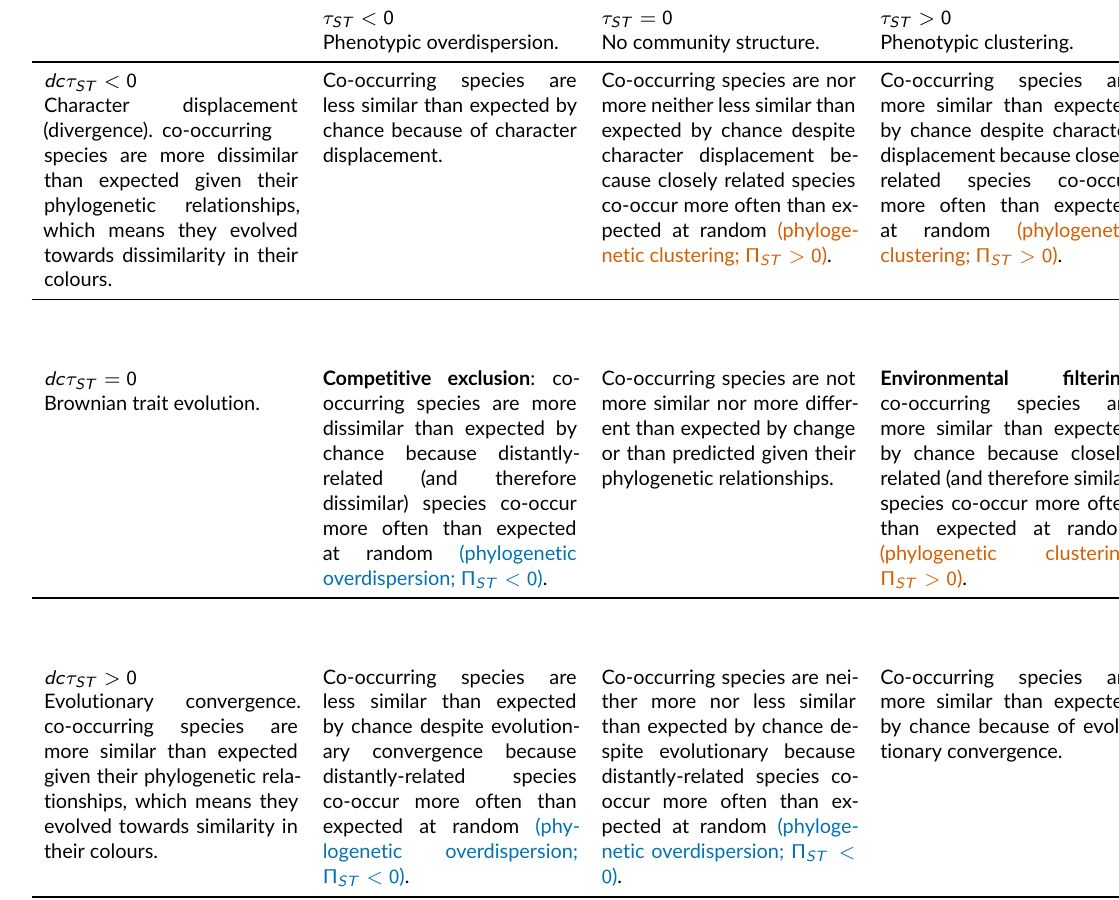
Table 1 – Summary of the different evolutionary and ecological scenarios and their results in terms of values of τ ST and decoupled dc τ ST